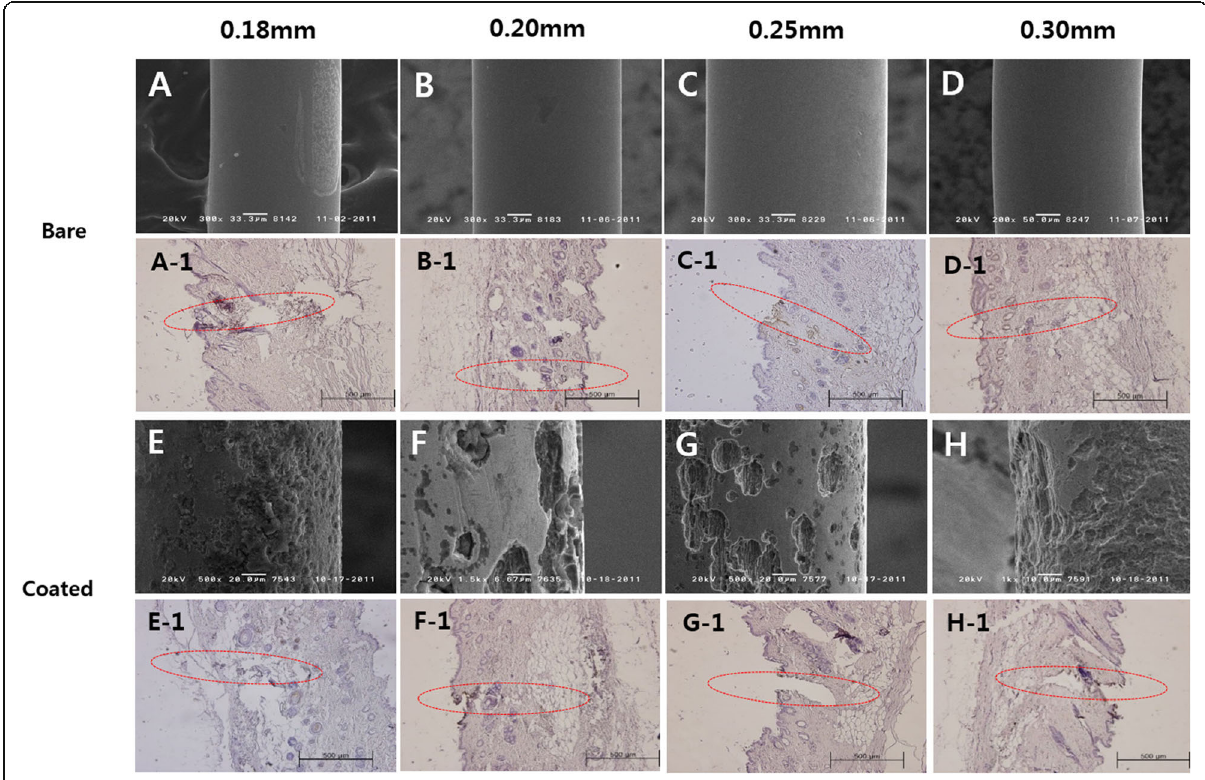
Fig. 4 Electron micrographs of STS316 needles after applying EA to tissues, and TUNEL assay results. a , b , c , d : Non-coated STS316 needle, e , f , g , h : Coated STS316 needles, and dashed figure is TUNEL assay correponding with its panel label. After applying electricity, corrosion was not observed in non-coated STS316 needles, as shown by electron microscopy. In coated STS316 needles, corrosion was observed such that parts of the needle had fallen apart and grooves had formed. The TUNEL assay results showed suspected cell necrosis (brown-colored TUNEL-positive areas) in areas where non-coated 0.25-mm STS316 needles (C-1), coated 0.2-mm STS316 needles (F-1), and coated 0.3-mm STS316 needles (H-1) had been inserted. The needle insertion sites are circled